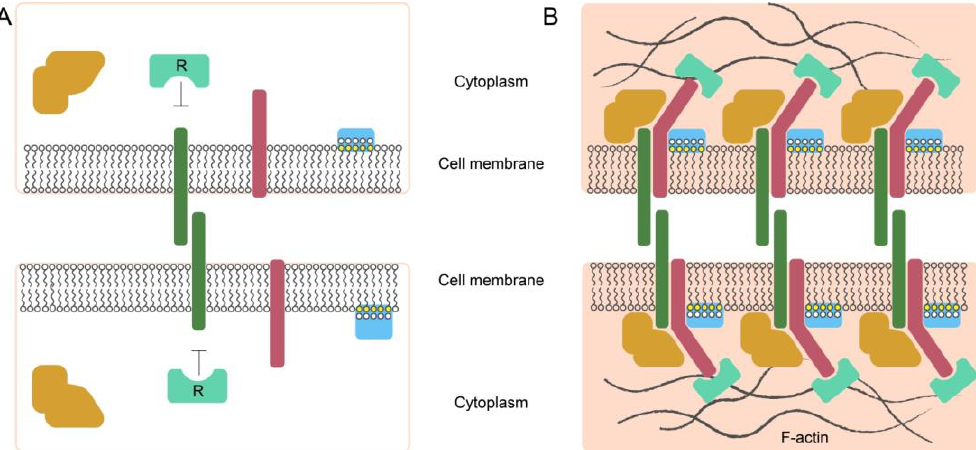
Figure 1. Illustration of individual molecules freely diffusing on the membrane surface ( A ), and a cluster of the intercellular adhesive complexes ( B ). Adhesion molecules (deep green) initiate binding, which also may involve other transmembrane proteins (pink) and cytoplasmic proteins that can bind to the cytosolic part of the transmembrane proteins (orange). It also involves lipid groups present on the inner surface of the plasma membrane (yellow) and proteins with lipid-binding domains (light blue). Clustering may lead to the displacement of negative regulators associated with the cytosolic part of the adhesion molecules (R). Actin microfilaments stabilize macromolecular clusters through actin-binding proteins (cyan) (modified from [91] ).